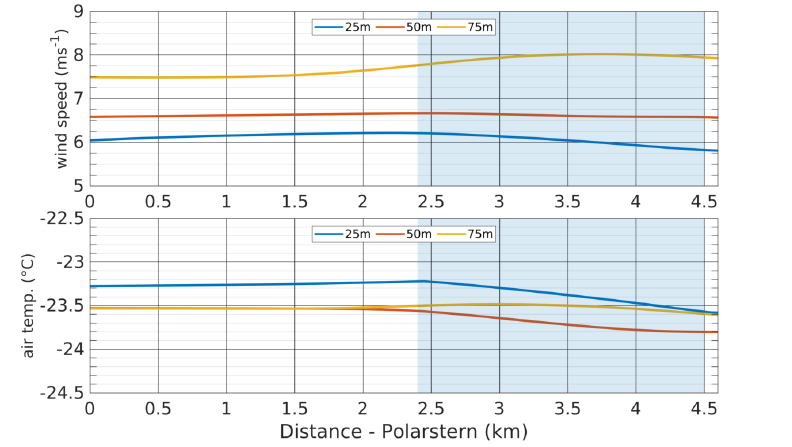
Figure 17. Wind speed in m s − 1 ( top ) and atmospheric temperature in ◦ C ( bottom ) at different height levels (25m, 50m, and 75m) obtained from an idealized simulation of the lead observed on 2 August 2013 with the non-eddy resolving model METRAS. The results are shown with respect to the distance to RV Polarstern in km (see Figure 13), as in Figures 14 and 15. The flow is from right to left and the position of the lead is denoted by the blue rectangle between 2.4km and 4.5km distance. The observed small crack between 0.5 and 1.1km distance (see Figure 13) is not considered in the